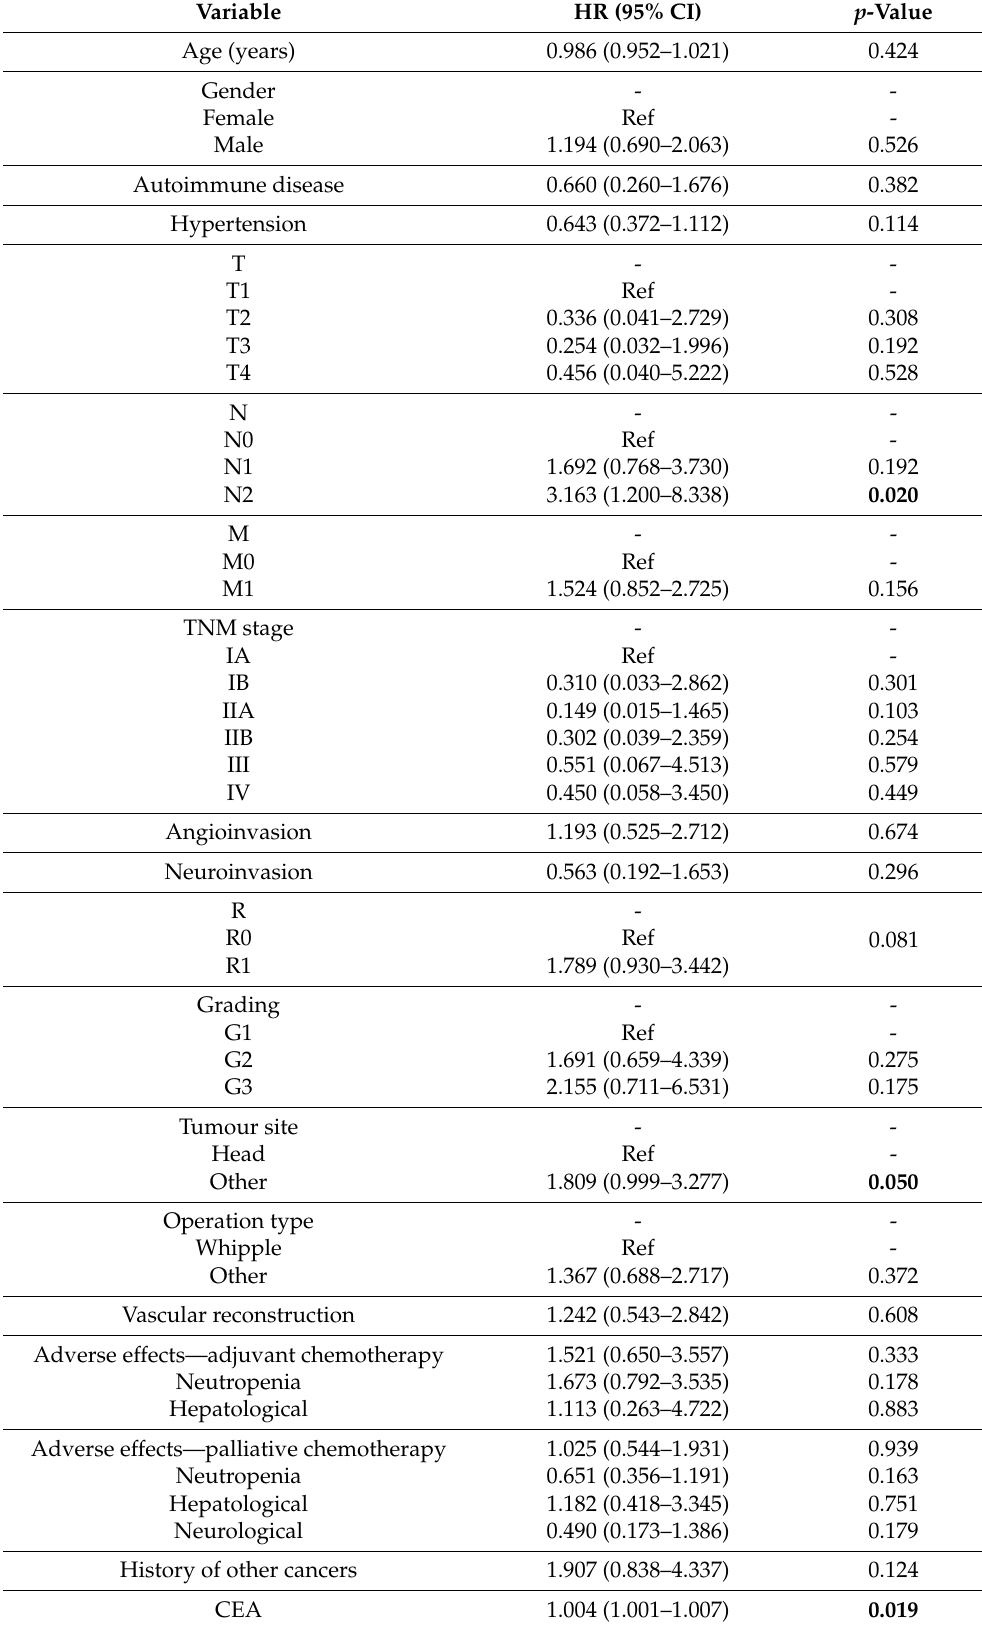
Table 2. Univariate analyses of prognostic factors for overall survival—DM